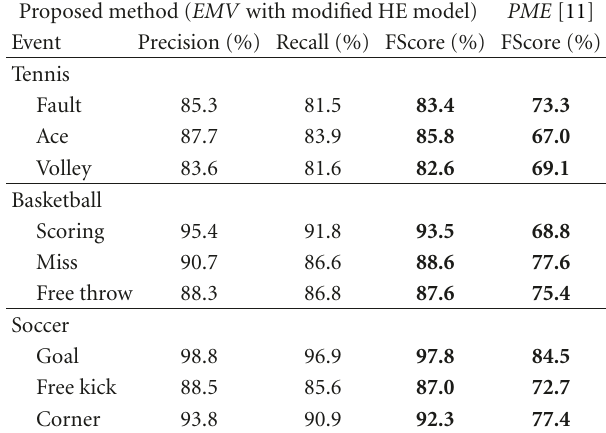
Table 3: Comparison of experimental results among triangle